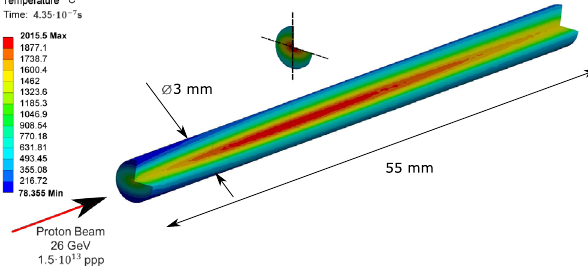
FIG. 4. 3 = 4 cut view of the temperature profile in the target core at the end of a single 26 GeV proton beam impact.